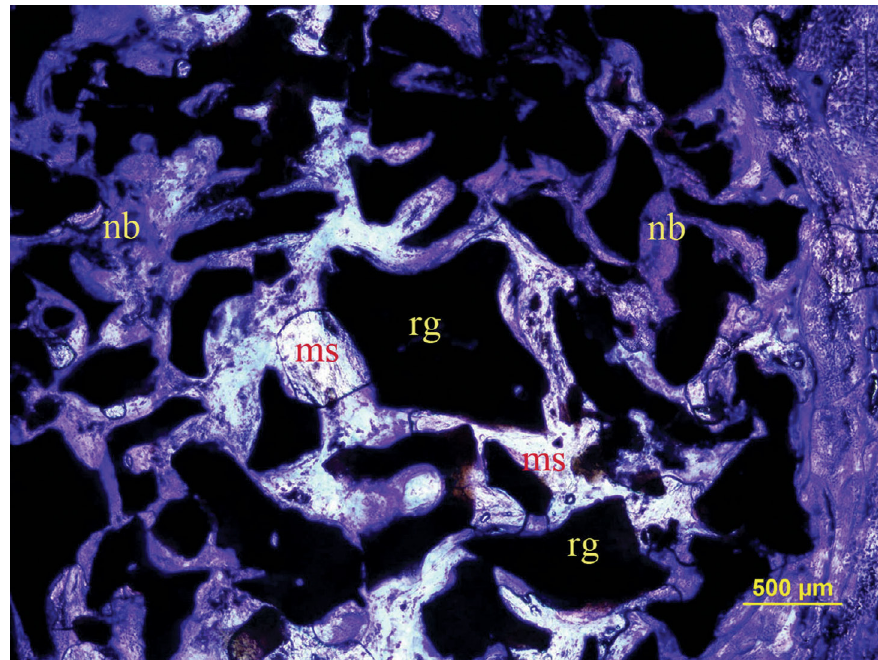
Figure 3- Histological transversal section stained with toludine blue in xenograft + HA group (original magnification 4×). nb: new bone; ms: marrow space; rg: residual graft particles